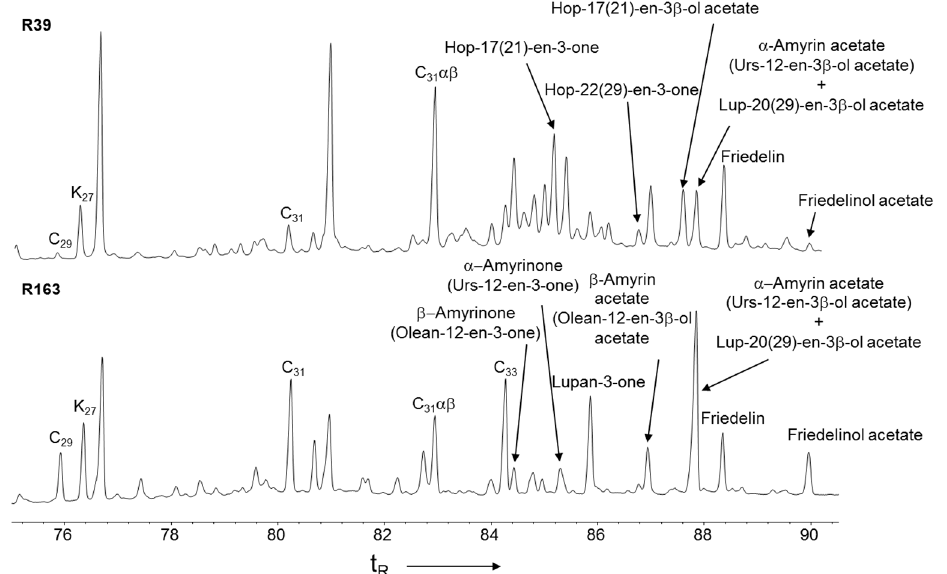
Figure 3. Total Ion Current (TIC) chromatographic traces of two selected samples from the upper and lower part of the Roñanzas profile at 39 and 163 cm (R39 and R163) in the high retention time (t R ) region where triterpenoid acetates appear. In the chromatogram are also identified some of the n -alkanes (C n ) and the C 31 αβ R-Homohopane (C 31 αβ R).